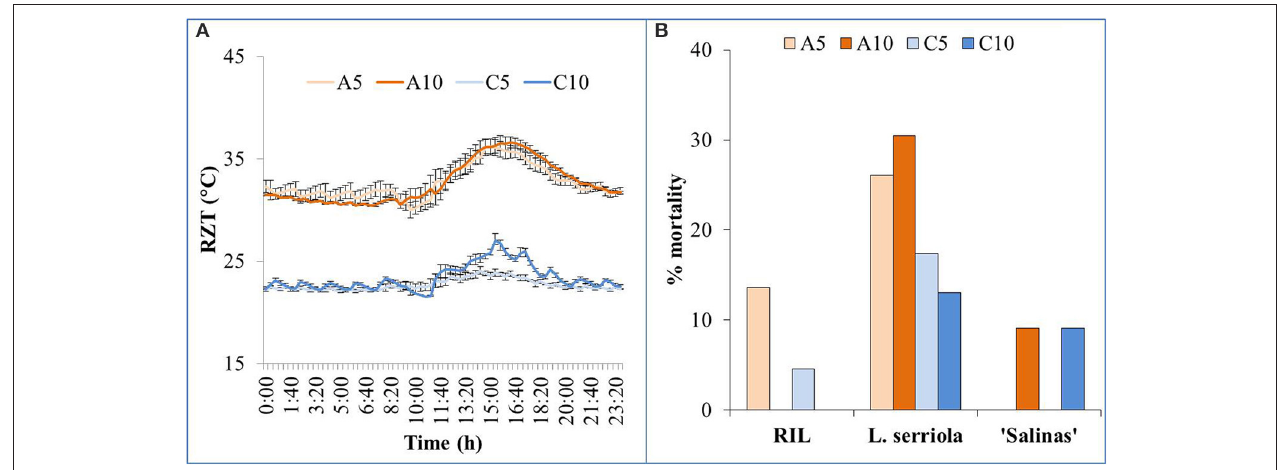
FIGURE 1 | (A) Range and variability of RZT of the four experimental conditions (A5, A10, C5, and C10) for the 3 plant types, with SE bars showing the variability across the 28-day growing period. (B) 22 seedlings of all plant genotypes were grown in the 4 RZ treatments and mortality was observed. Graph shows the % mortality of each genotype in each of the 4 RZ treatments, at harvest, 28 days after transplanting.